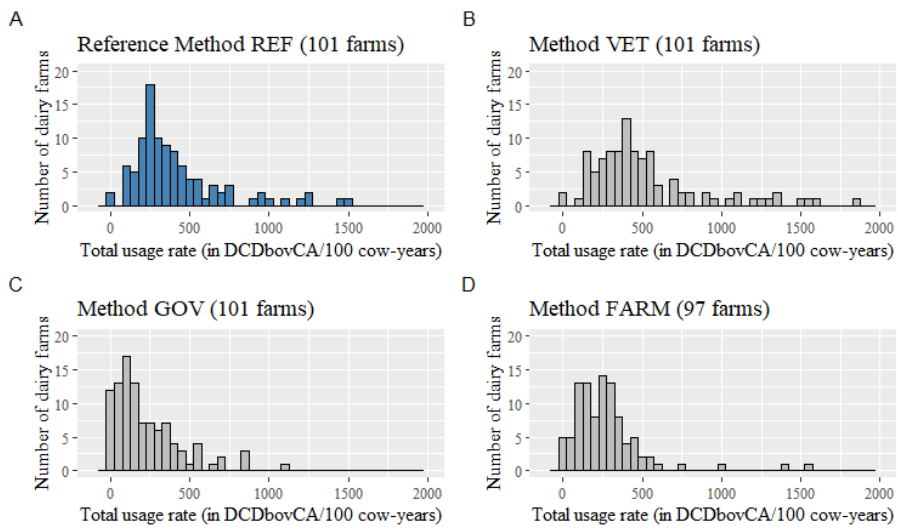
Figure 1. Distribution of the total antimicrobial usage rate (from products other than medicated feed) in Canadian Defined Course Doses for cattle (DCDbovCA)/100 cow-years, quantified using four different methods from 101 Québec dairy farms: ( A ) garbage can audit (REF method), ( B ) all veterinary invoices (VET method), ( C ) veterinary invoices eligible for the Québec governmental program (GOV method), and ( D ) farm treatment records (FARM method; note that farm treatment records could be retrieved from only 97 dairy farms).